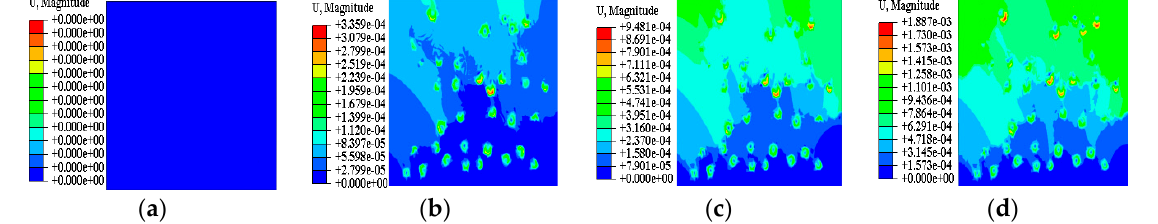
Figure 11. Axial displacement nephogram of model 1 at different stages. ( a ) Step Time = 0; ( b ) Step Time = 0.37; ( c ) Step Time = 0.52; ( d ) Step Time = 1.